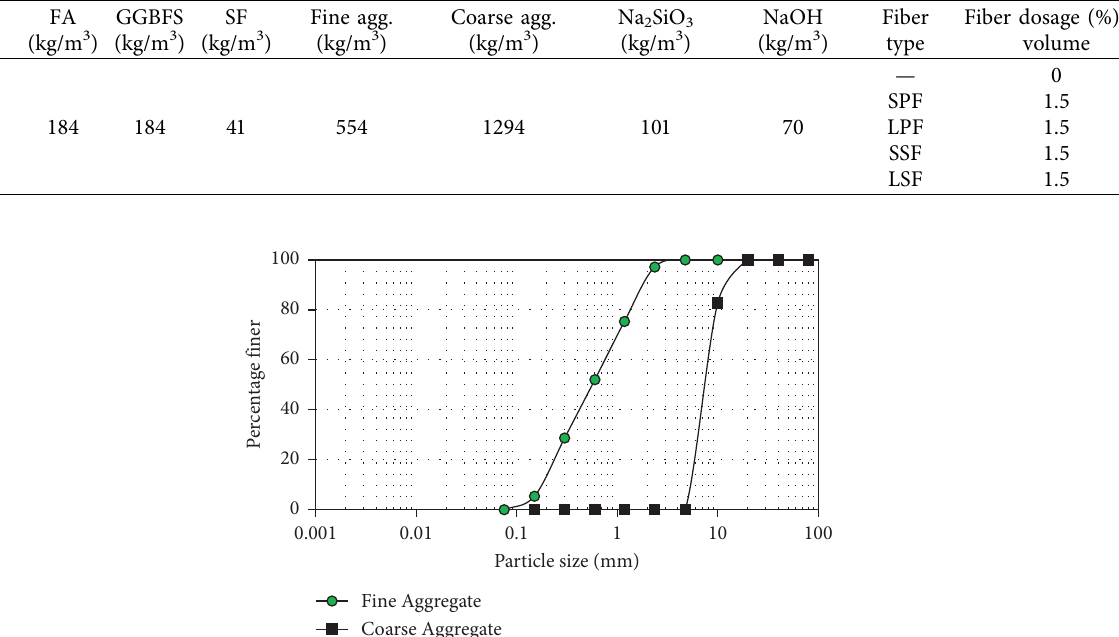
Table 3: Mixing composition.